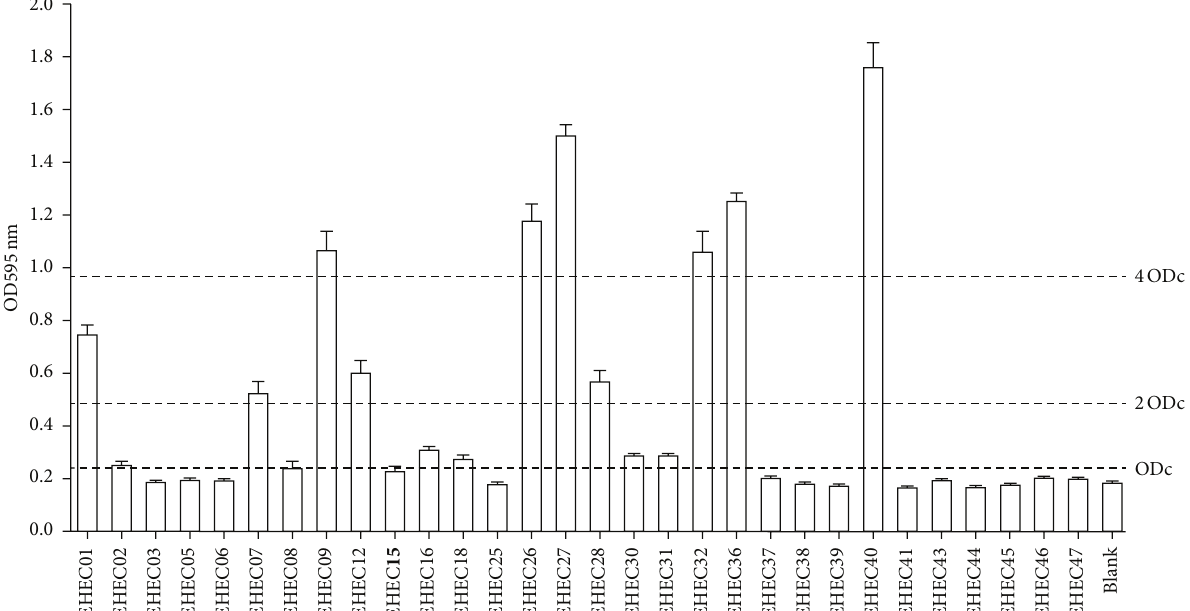
Figure 1: Biofilm formation by EHEC O157 isolates. Biofilm formation by EHEC O157 isolates on polypropylene microtiter plates following incubation for 24 h at 37 ∘ C in LB broth without salt (LB-NS). All experiments were repeated at least three times. The columns represent the mean ± standard deviations of the data. Comparisons of the OD values produced by bacterial biofilms to the ODc values were used to classify the strains (non-biofilm producer, weak, moderate, or strong). The cut-off OD (ODc) value was defined as three standard deviations above the mean OD of a blank control. Strains were classified as follows: OD < ODc = no biofilm production; ODc < OD < (2 ODc) = weak biofilm producer; (2 ODc) < OD < (4 ODc) = moderate biofilm producer; and (4 ODc) < OD = strong biofilm